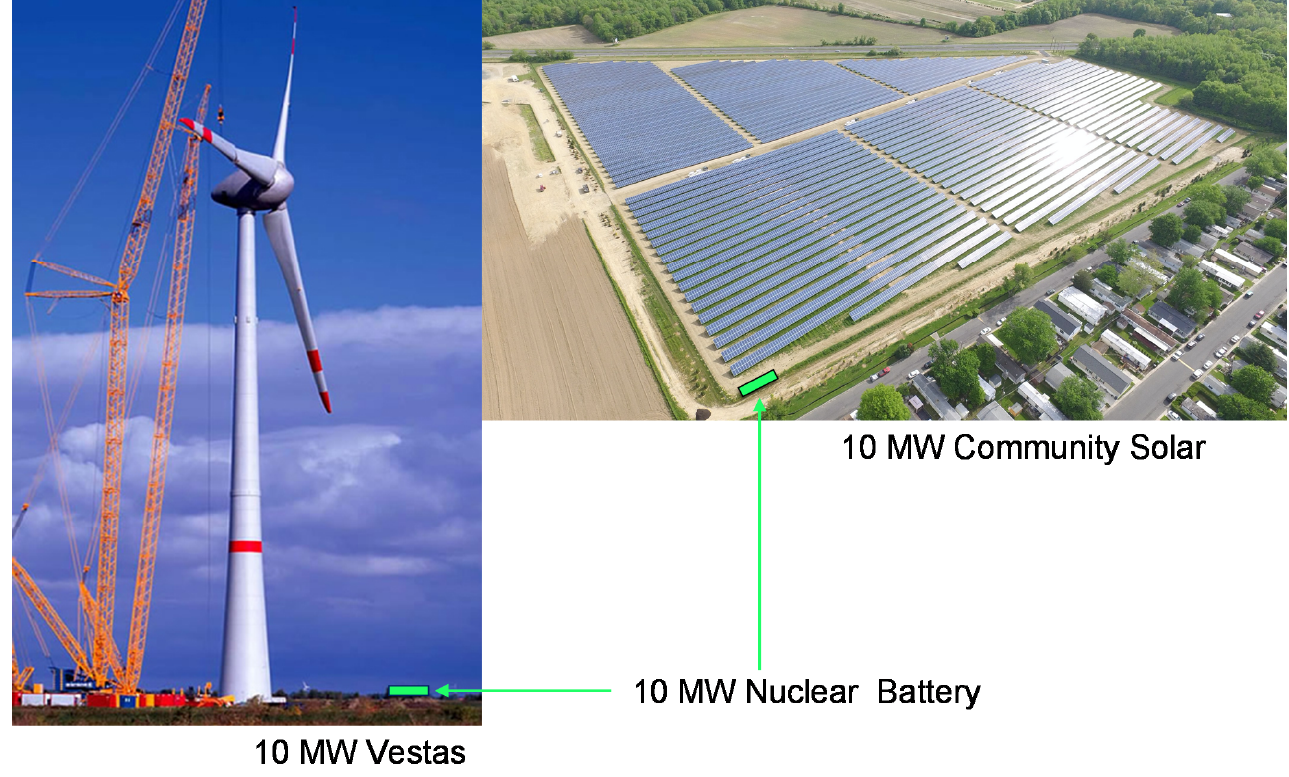
Figure 3. Size comparison of a 10 MW NB (green rectangle) vs. 10 MW of wind (Vestas 164) and 10 MW of solar (NJ Altus solar farm).